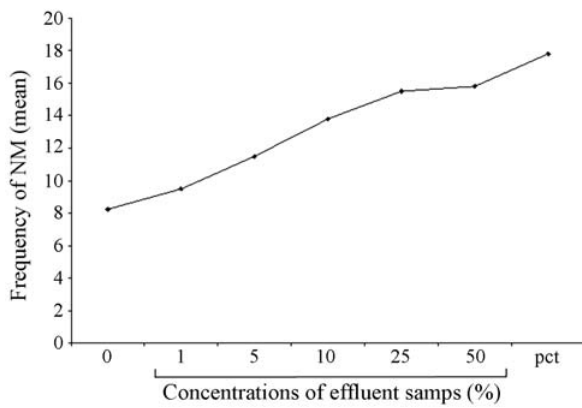
Figure 4 - Frequency of MN induced in bone-marrow cells of mice ex- posed to the pharmaceutical effluent Zero: negative control (distilled wa- ter) Pct. Positive control (cyclophosphamide 20 mg/kg body weight).